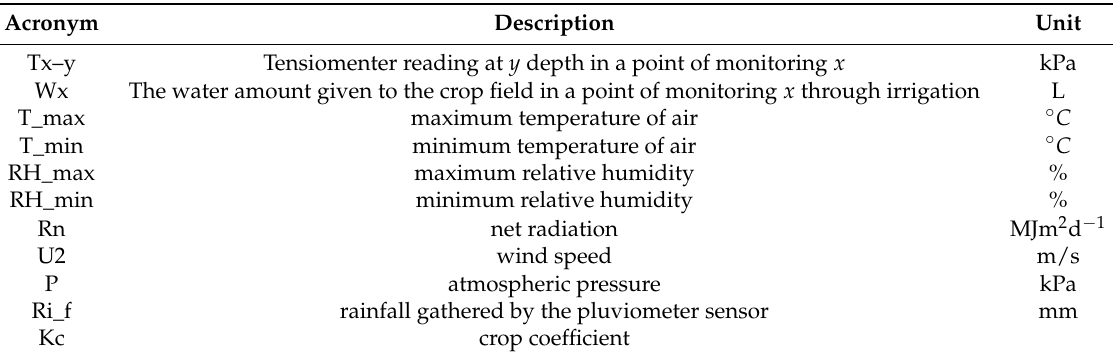
Table 1. Raw dataset